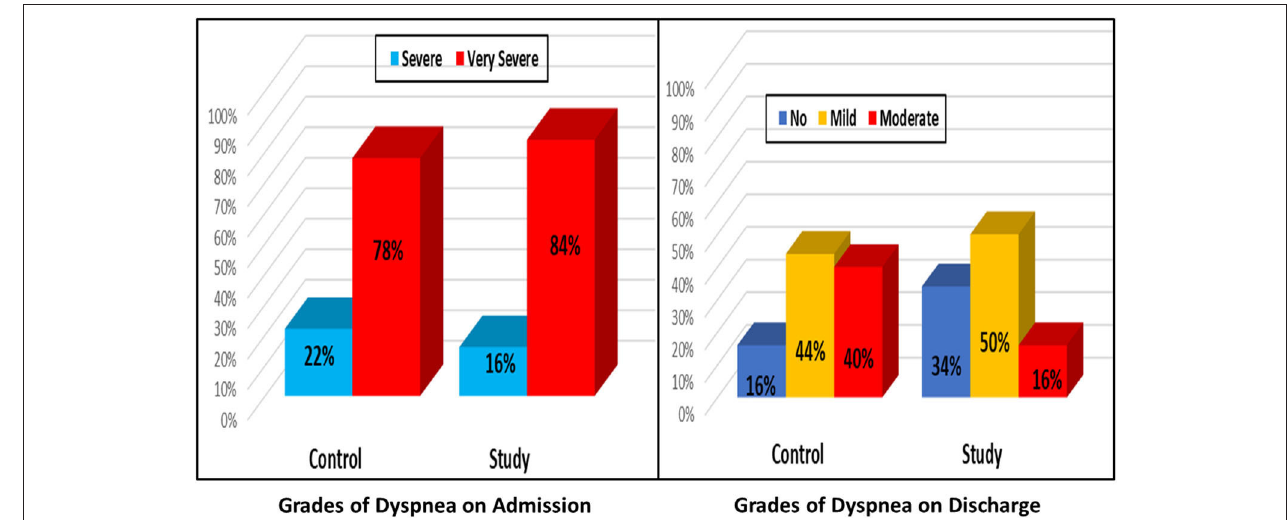
FIGURE 3 | Change in the dyspnea grades on admission vs on discharge.